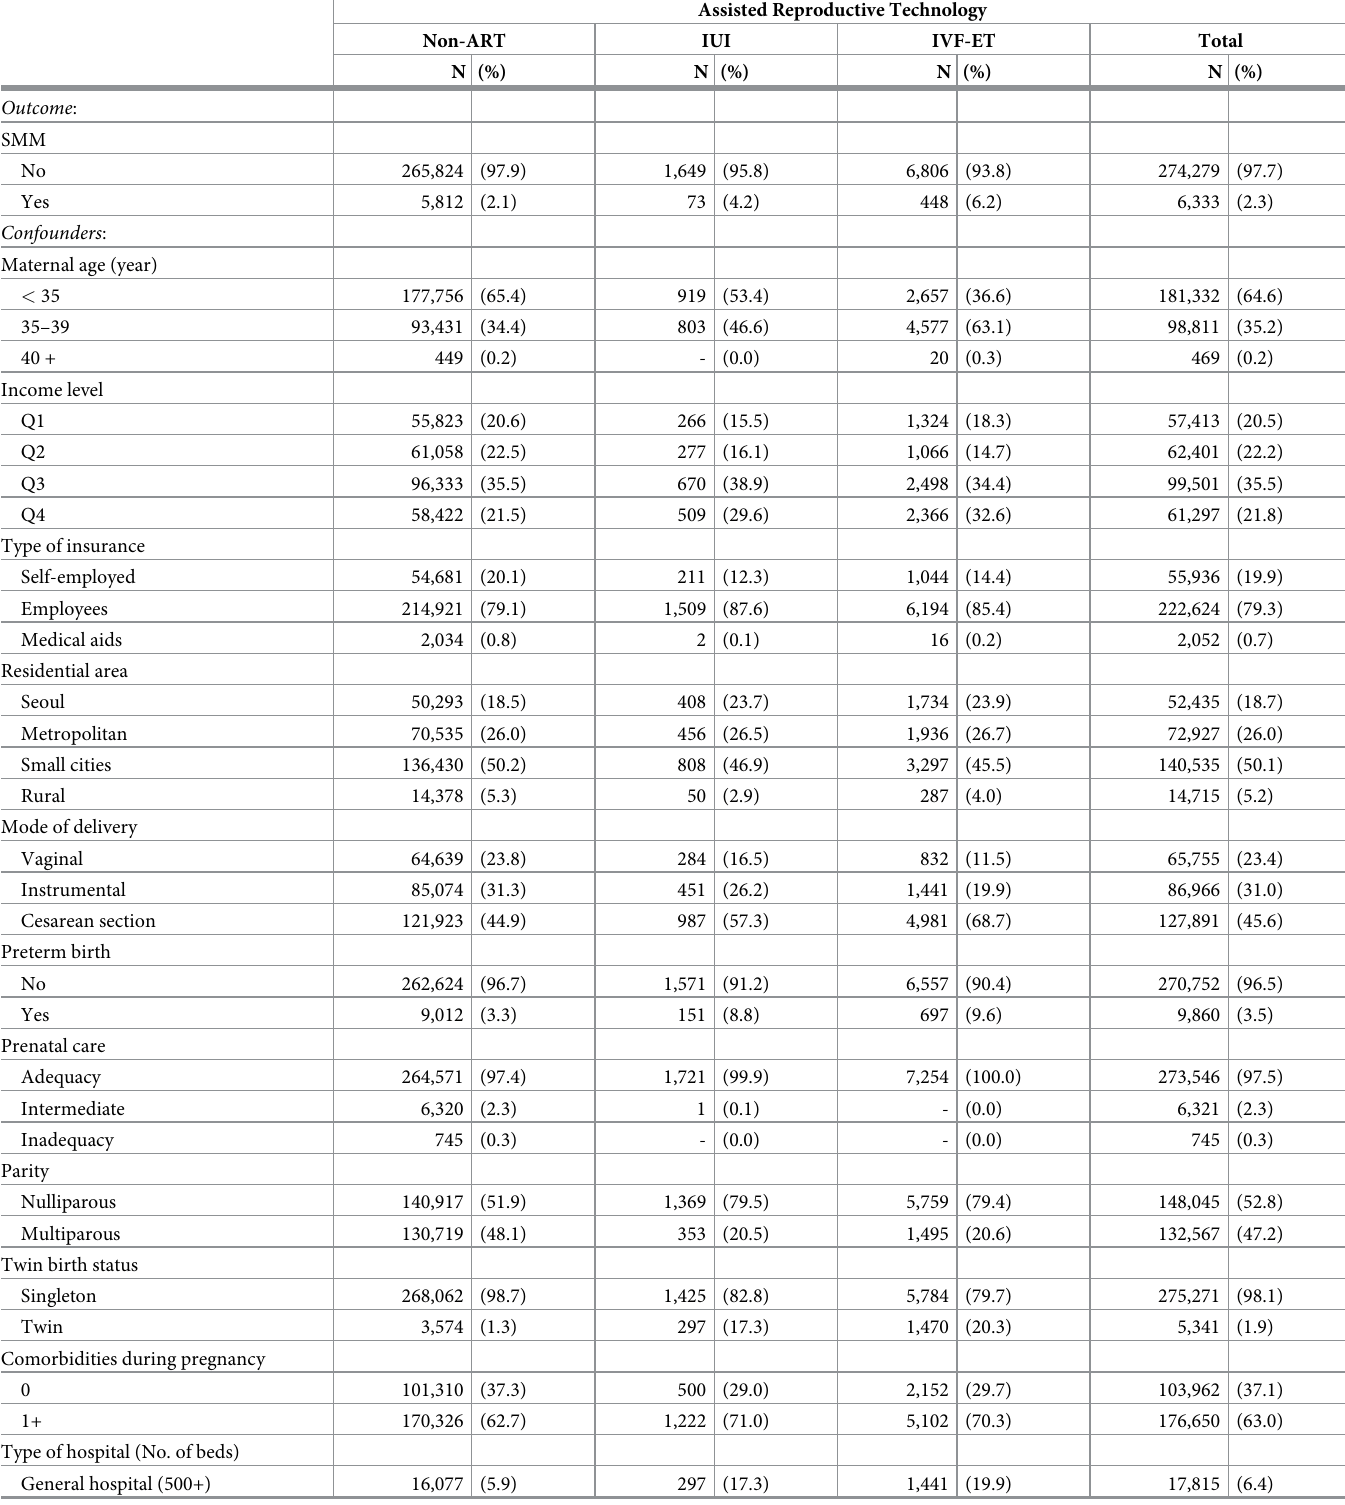
Table 1. General characteristics of the study